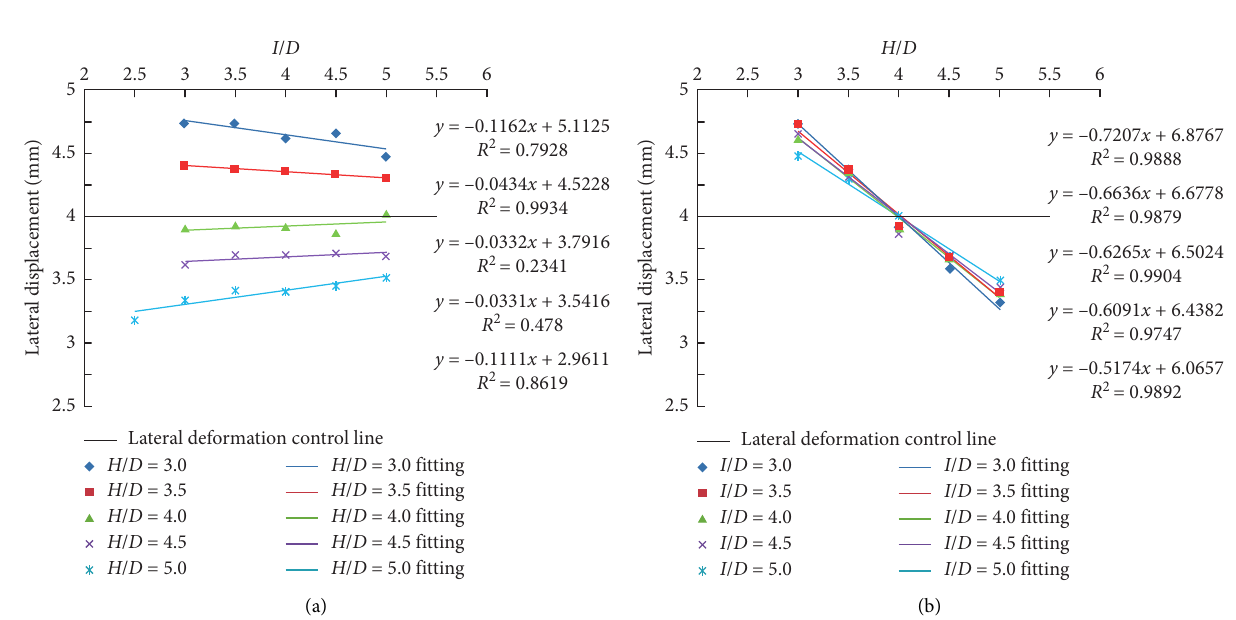
Figure 10: Variation of the maximum value of lateral deformation with H / D and I / D respectively. (a) Variation of the maximum vertical deformation of each working condition with I / D under different H / D . (b) Variation of the maximum vertical deformation of each working condition with H / D under different I / D .